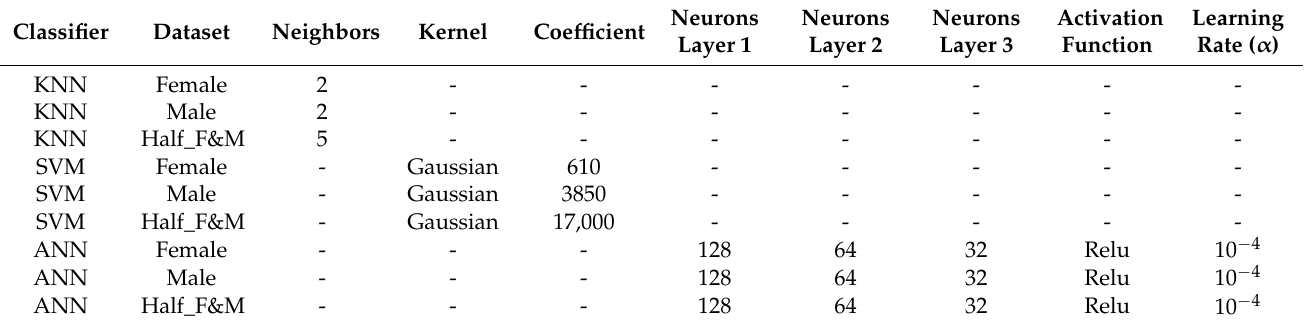
Table 5. The optimal configurations of k-NN, SVM and ANN classifiers for differentiating sex datasets obtained from the validation set.